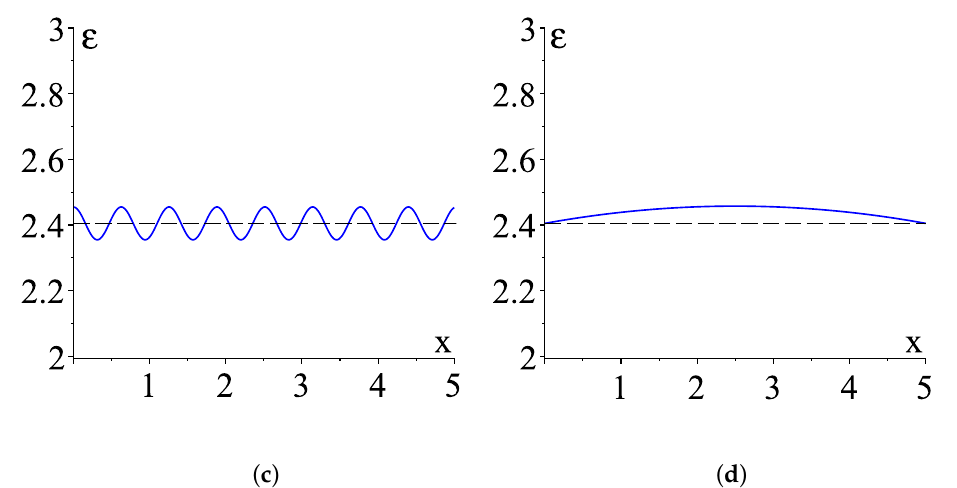
Figure 12. In subfigure ( a ) ε = 2.405, in subfigure ( b ) ε = 2.405 + 0.05cos ( x ) , in subfigure ( c ) ε = 2.405 + 0.05cos ( 10 x ) , in subfigure ( d ) ε = 2.405 + 0.00526 (